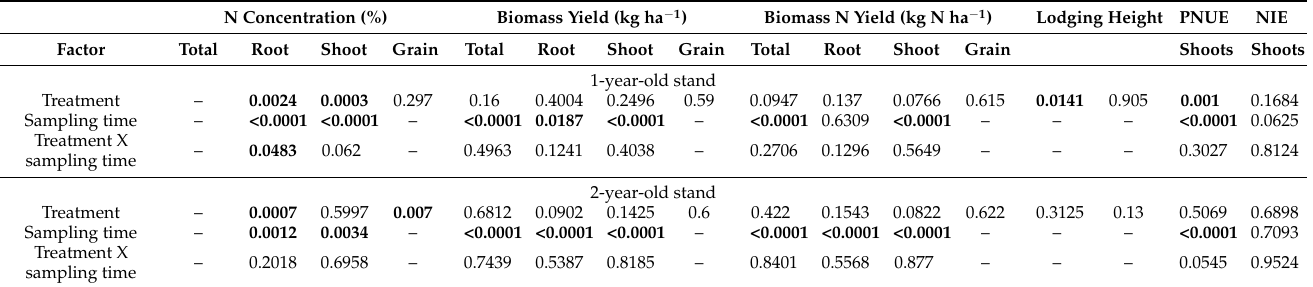
Table 2. Results of analysis of variance to test for significant nitrogen-addition treatment, sampling time, and interaction effects on plant variables.